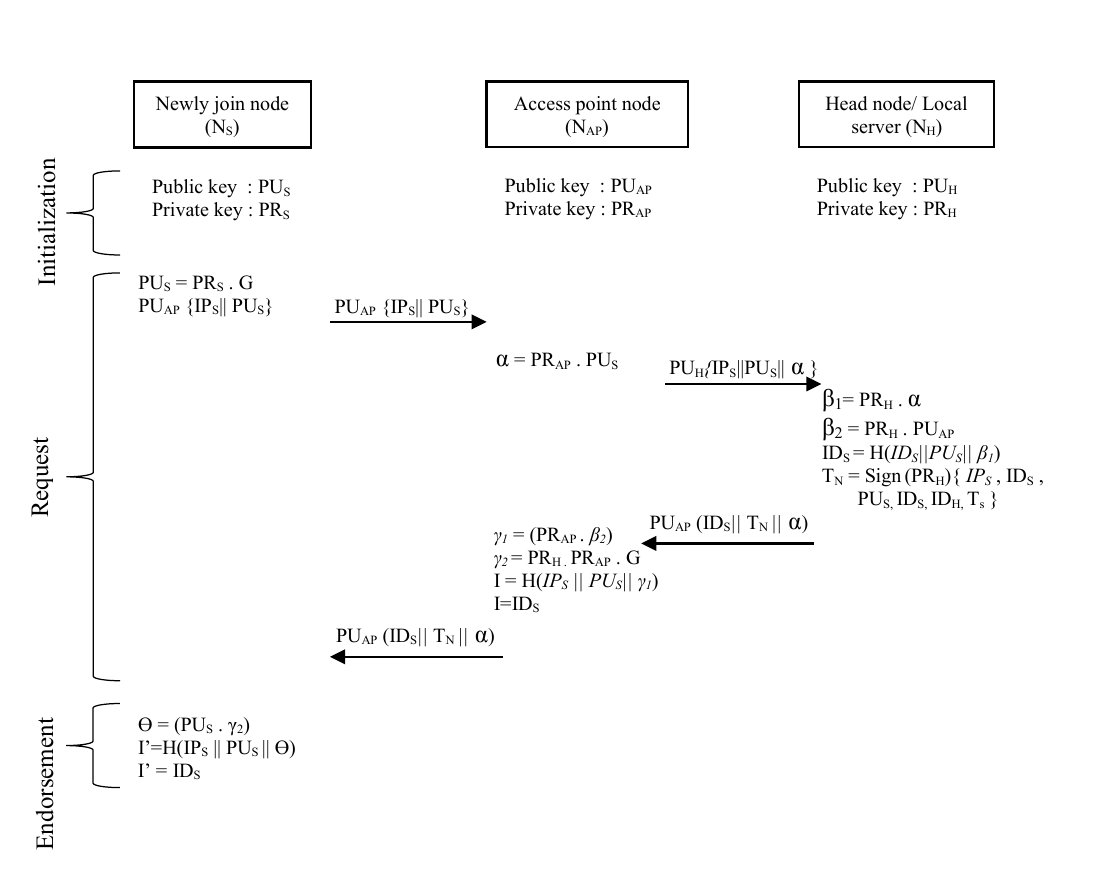
Figure 5. Schematic diagram of our prposed